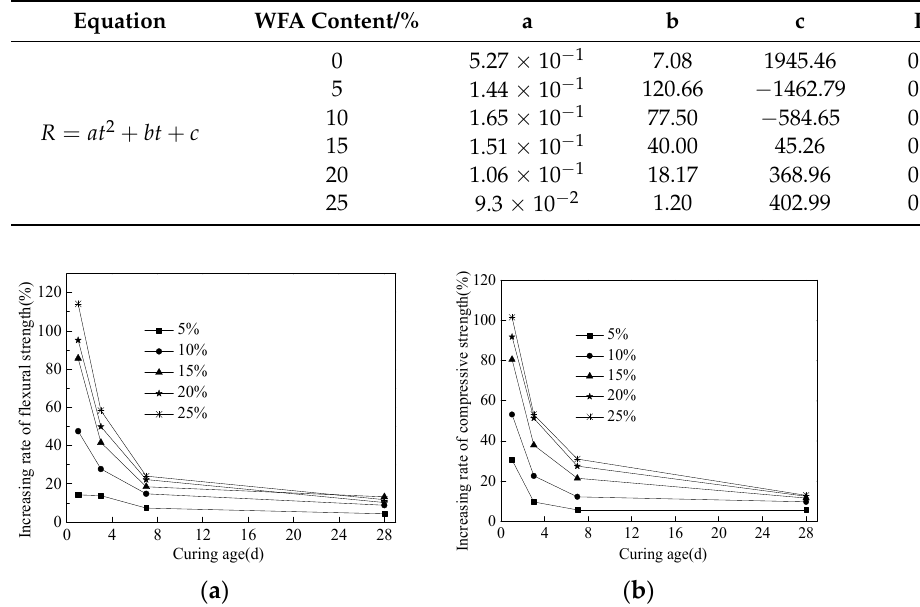
Figure 9. The mechanical strengths of cement paste with different dosage of waste fly ash. ( a ) Flexural strength, ( b ) Compressive strength. Table 4. The fitting results of electrical resistance and the curing time.